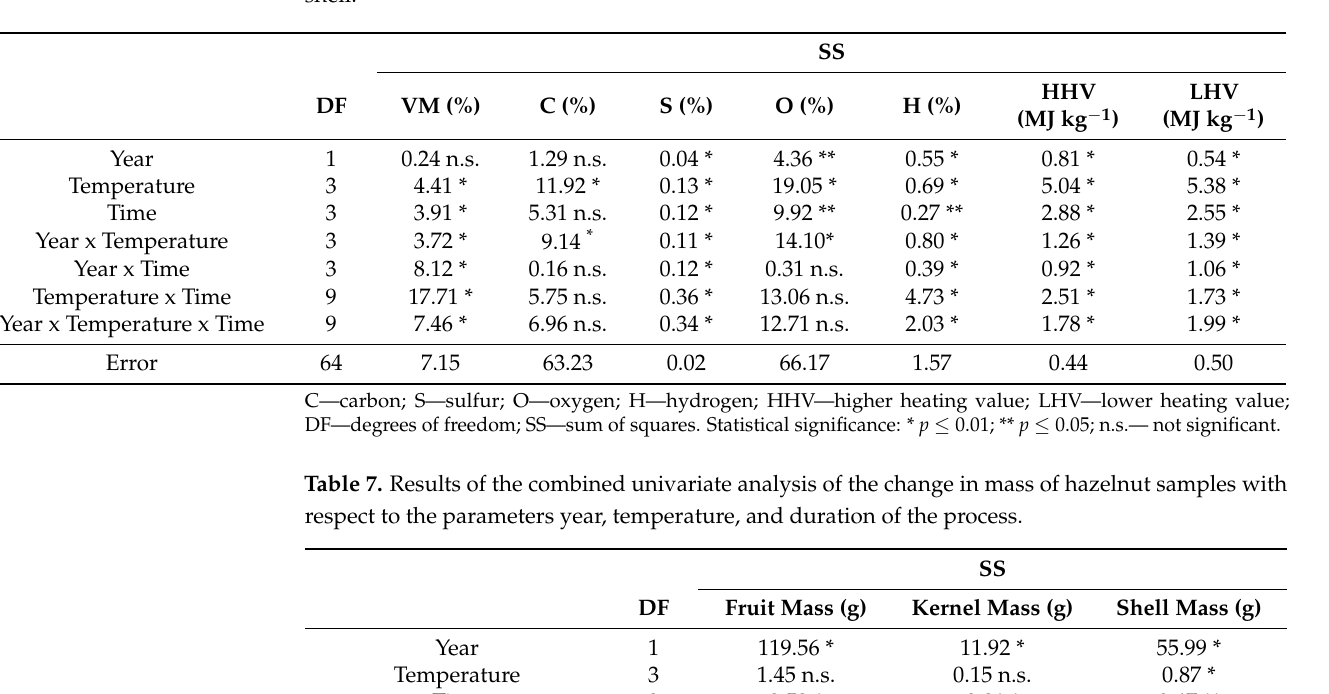
Table 6. Results of the combined univariate analysis of content of combustible substances in hazelnut shell.